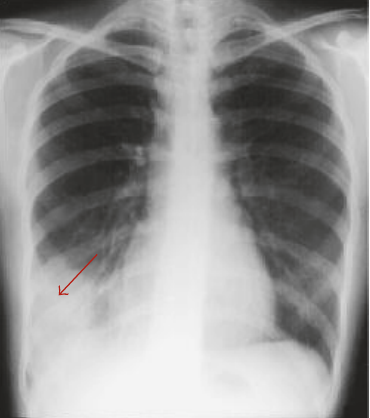
Figure 1: Example of lower-right lobar shadow (red arrow) from a representative PA radiograph.